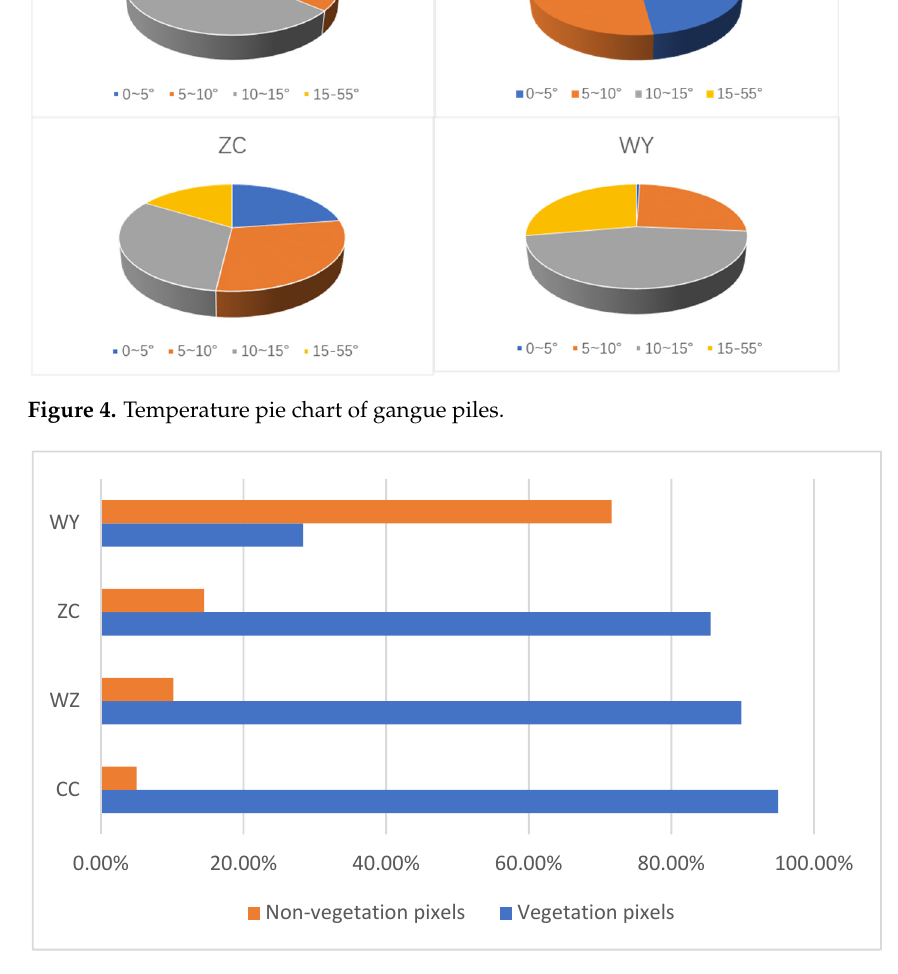
Figure 5. The ratio of vegetation pixels in coal gangue piles.